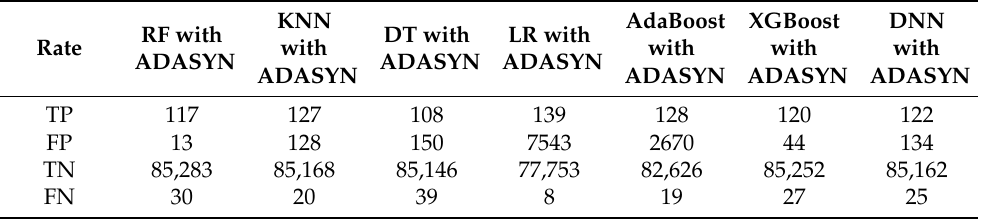
Table 11. TP, FP, TN, FN rates of machine learning algorithms with ADASYN based on resampling approach